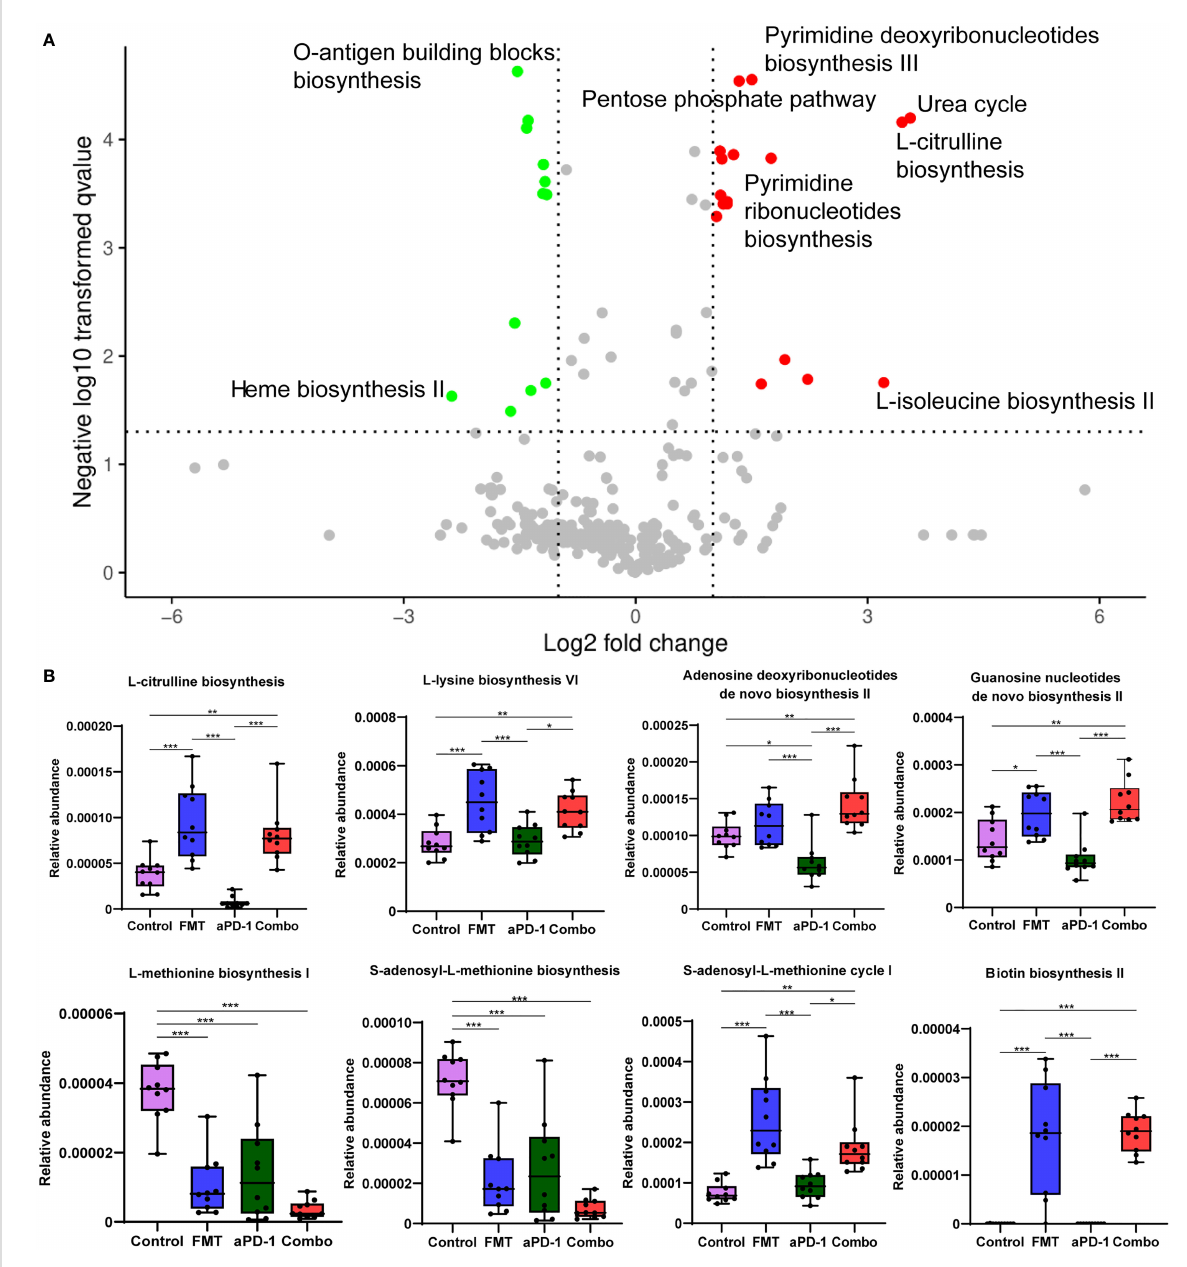
FIGURE 3 The effect of FMT and PD-1 antibody administration on gut metagenomic gene pathways. (A) Volcano plot showing differentially expressed microbial gene pathways between Combo and aPD-1 groups. (B) Abundance of speci fi c gene pathways in different groups. Data are represented as mean ± SD. *, p -value < 0.05; **, p -value < 0.01; ***, p -value <